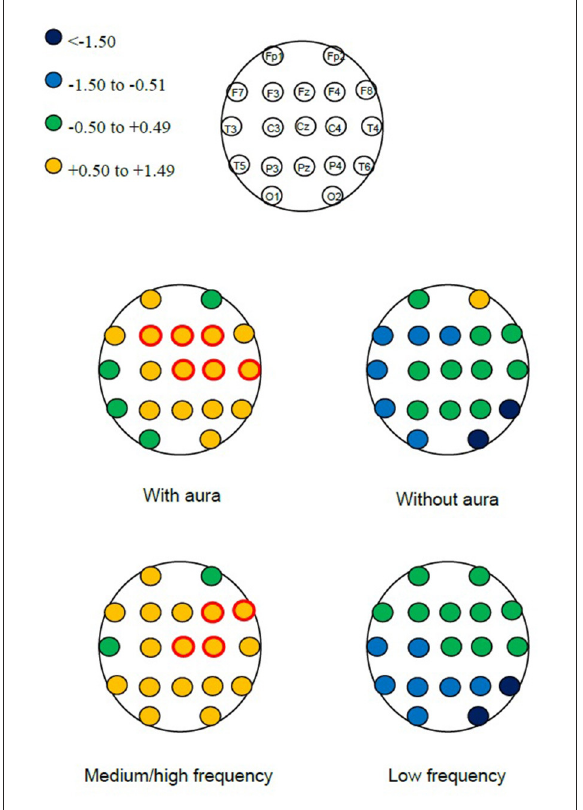
FIGURE1 Detailed scheme of electroencephalographic power change ( 1 P ) after vs. before microbubble injection in the overall frequency spectrum (4–45Hz) in subgroups of interest. Red circles identify changes with p <